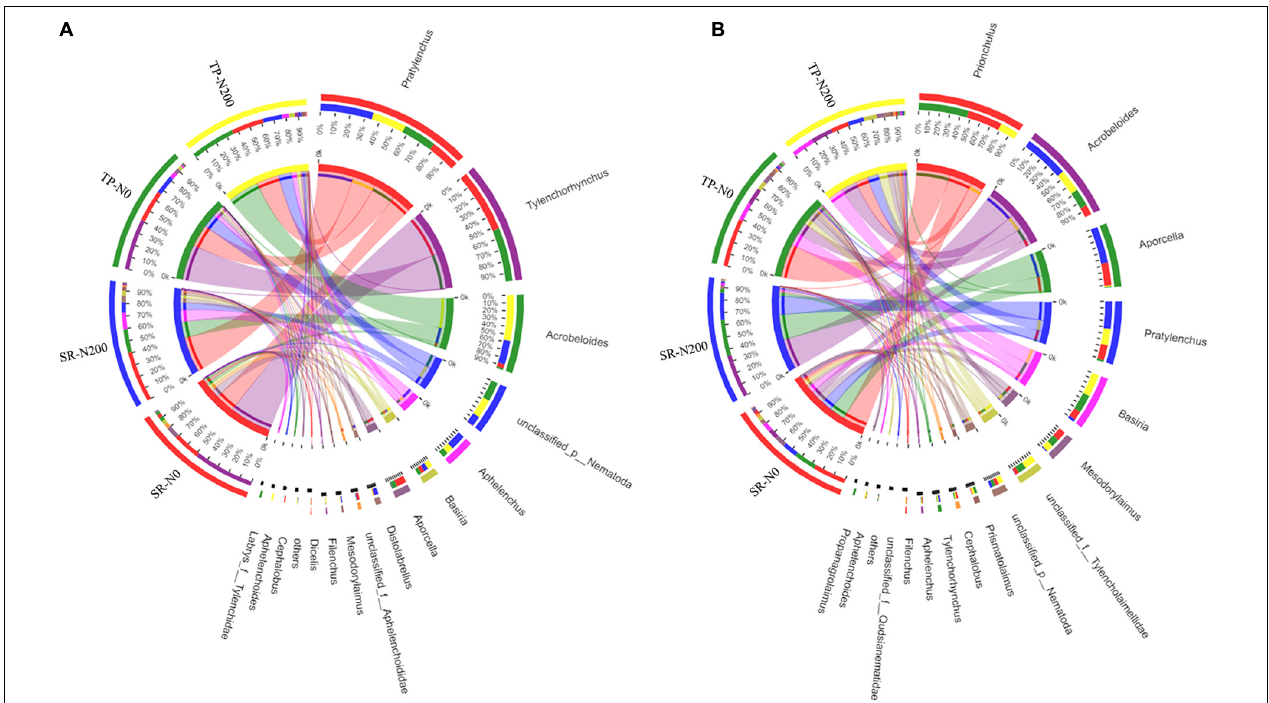
FIGURE 5 | Relative abundances of nematode at the genes level in spring (A) and autumn (B) seasons. SR-N0 = straw returning without N fertilizer application; SR-N200 = straw returning with 200 kg ha − 1 N fertilizer application; TP-N0 = traditional planting without N fertilizer application; TP-N200 = traditional planting with 200 kg/ha nitrogen fertilizer